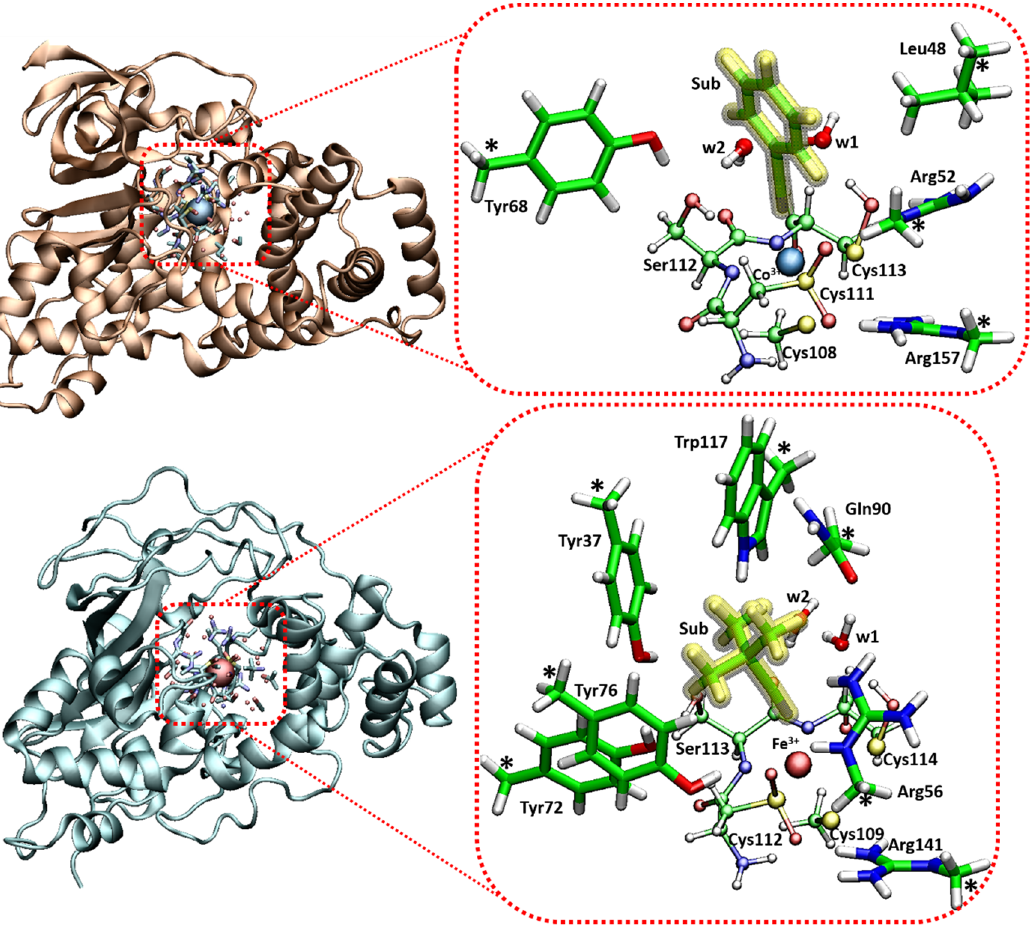
Figure 5. QM cluster model of Co 3+ - (top) and Fe 3+ -NHase active site (bottom), including the benzonitrile and pivalonitrile substrates, respectively. Stars indicate the locked atoms frozen during the calculations.